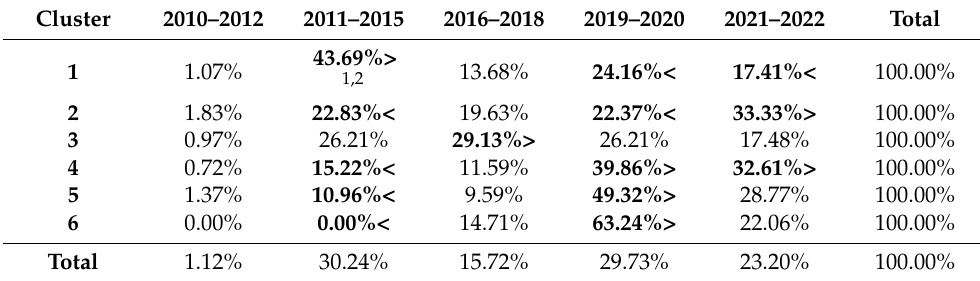
Table 8. Distribution clusters by year of reporting of sequences from clinical isolates.